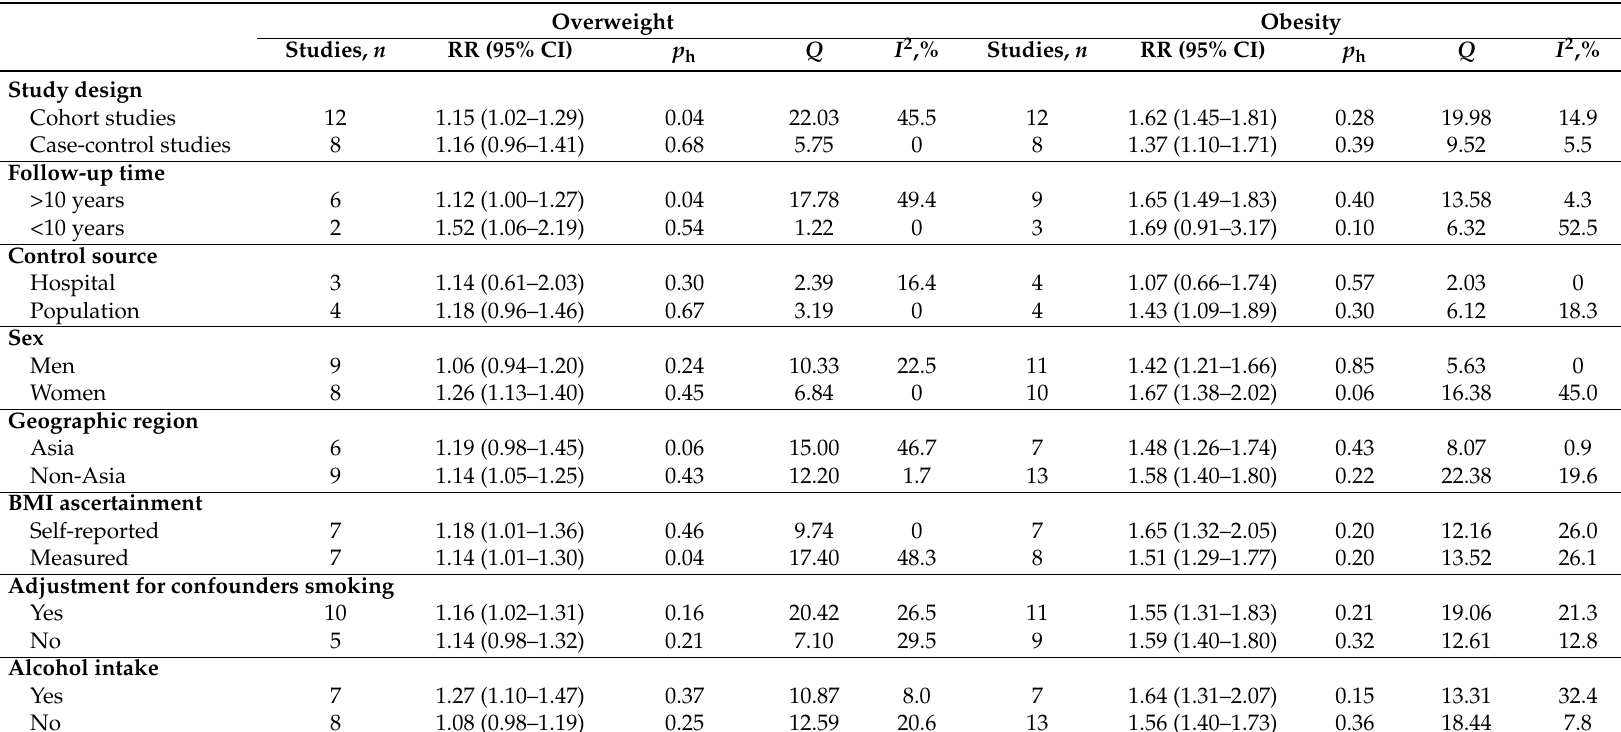
Table 3. Subgroup analysis of relative risks for association between body mass index (BMI) and gallbladder cancer risk. Overweight